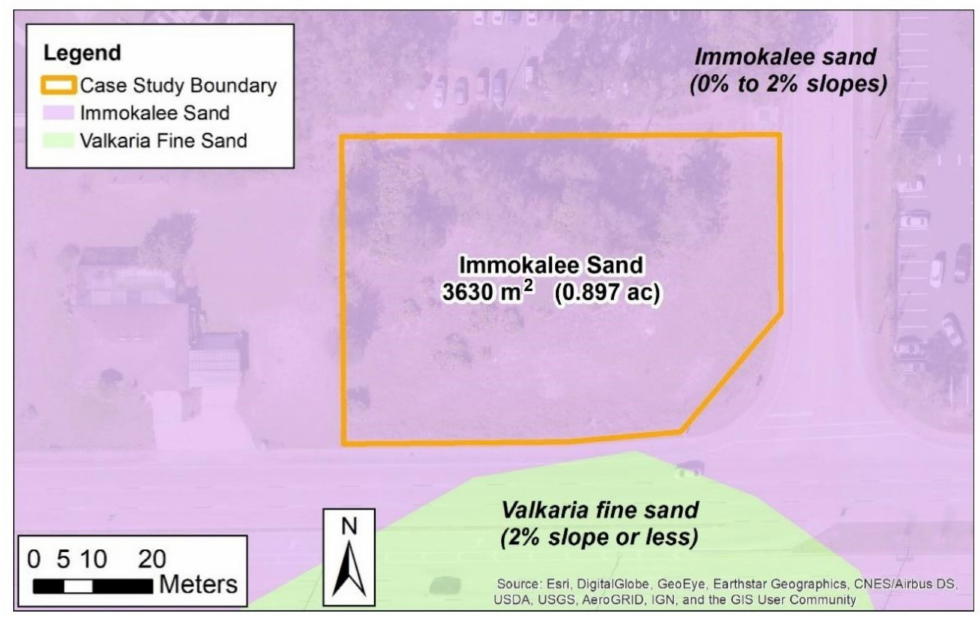
Figure 2. Predevelopment arenosol